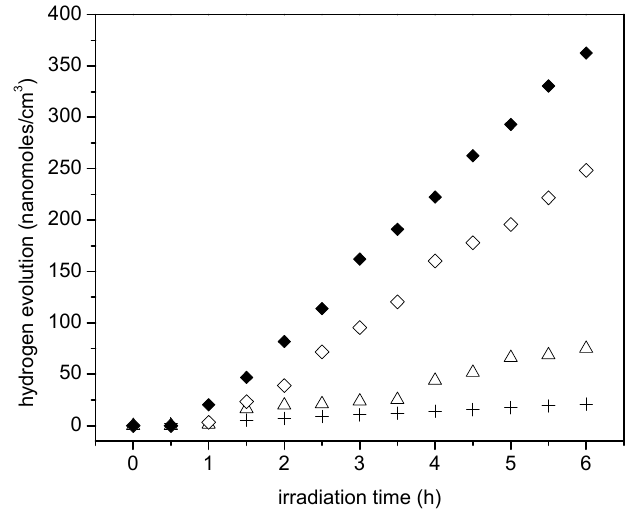
Figure 9. Cumulative hydrogen formation under an argon atmosphere for various photocatalysts: ( ♦ , ◊ ) Pt–TiO 2 prepared via incipient wetness impregnation with 1.70 wt. % and 0.82 wt. % of Pt loadings on TiO 2 Degussa P25, ( Δ ) Degussa P25 and (+) Blank run [no photocatalyst]. Photoreaction conditions: pH = 4.00 ± 0.05, 2.00% v / v ethanol, photocatalyst loading: 0.15 g/L. Standard deviation for repeats was ±5%.